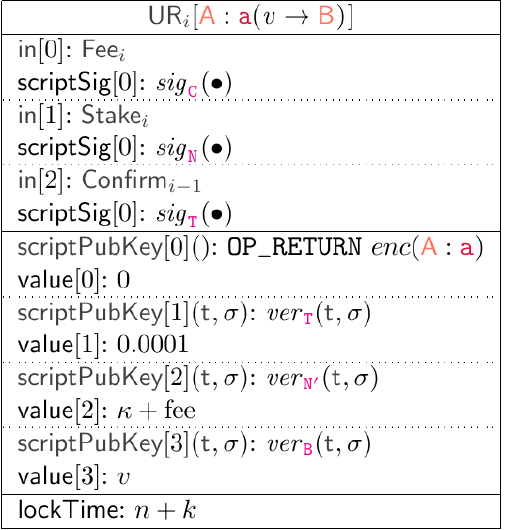
Figure 4. Encoding of an update request as a Bitcoin